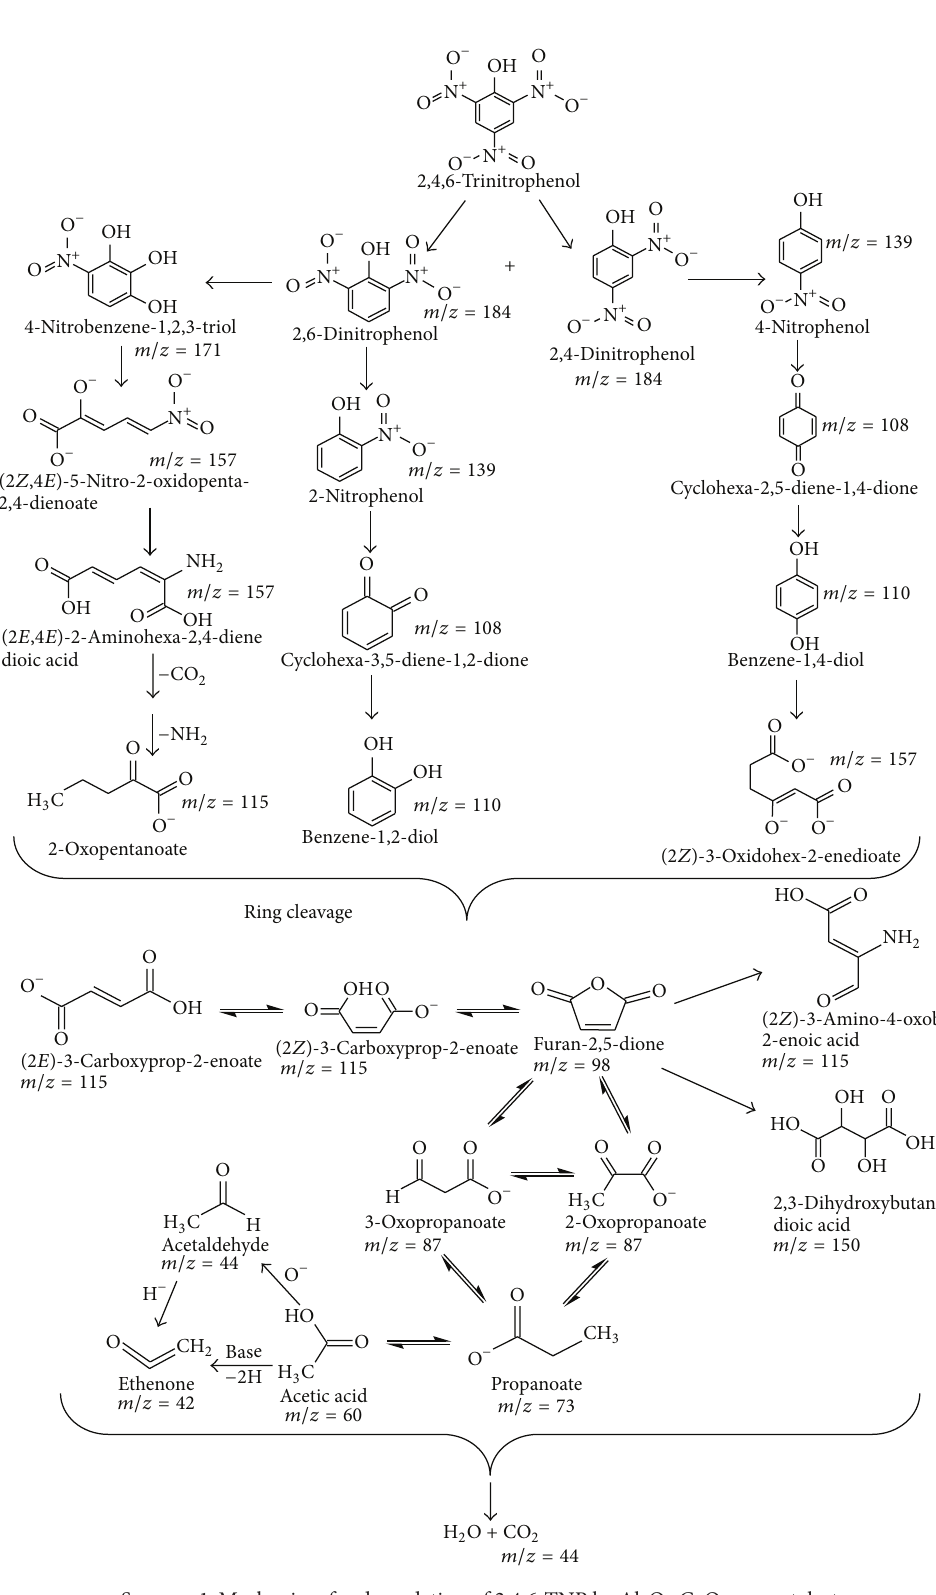
Scheme 1: Mechanism for degradation of 2,4,6-TNP by Al 2 O 3 ⋅ CaO